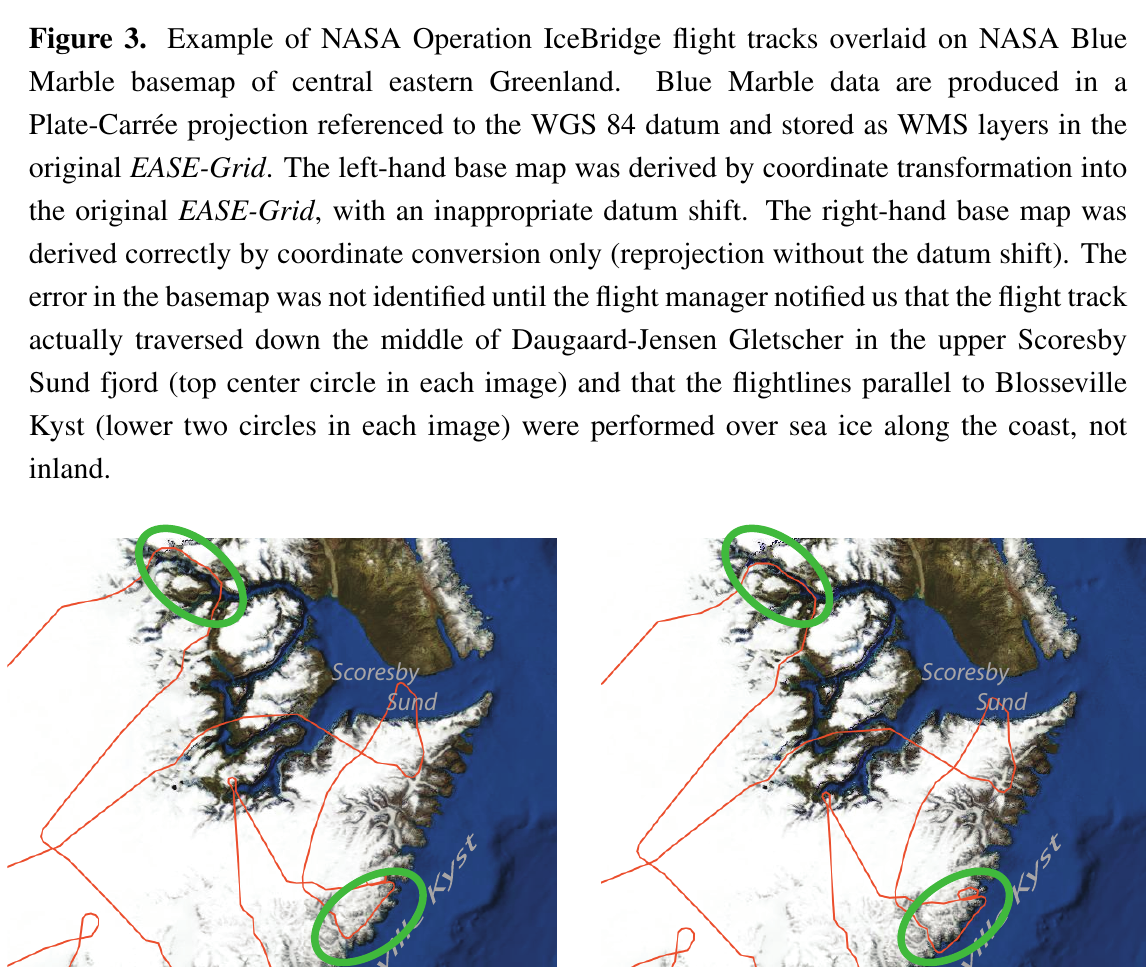
Figure 3. Example of NASA Operation IceBridge flight tracks overlaid on NASA Blue Marble basemap of central eastern Greenland. Blue Marble data are produced in a Plate-Carr´ee projection referenced to the WGS 84 datum and stored as WMS layers in